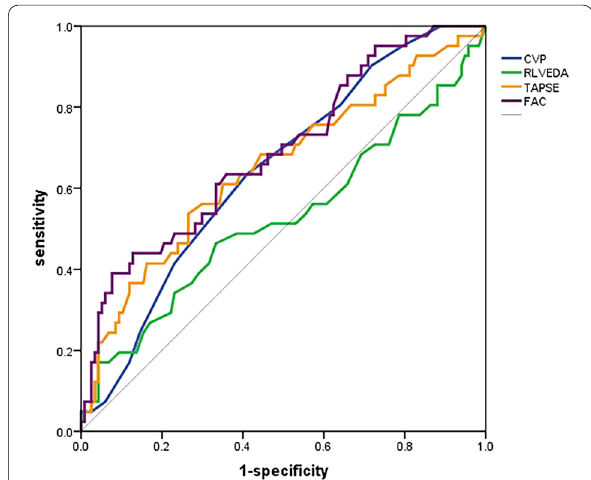
Fig. 3 ROC curve analysis of CVP, R/LVEDA, TAPSE, and FAC for 30 day mortality. CVP central venous pressure, R/LVEDA ratio of right and left ventricular end-diastolic area, TAPSE tricuspid annular plane systolic excursion, FAC fractional area change. The ROC analysis showed that the area under the curve for CVP, R/LVEDA, TAPSE and FAC were 0.644, p